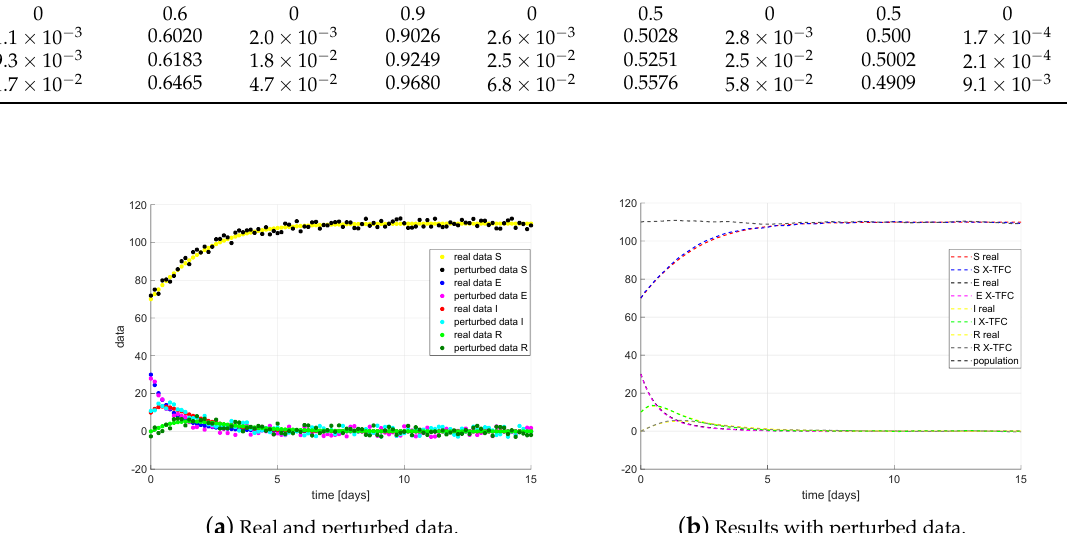
( b ) Results with perturbed data.